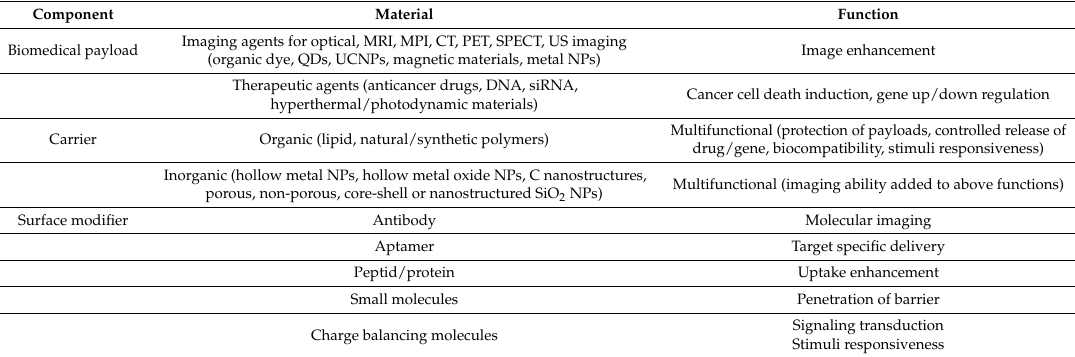
Table 1. Multifunctional NPs: materials and functions (adapted and reproduced with permission from [14]).